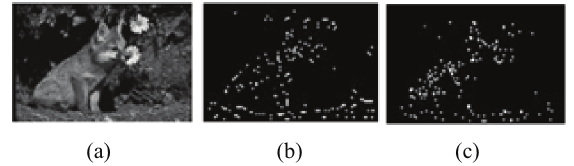
Figure 6:(a) Original image (b) Proposed method (171 salient points) (c) Loupias method [17] (171 feature points)